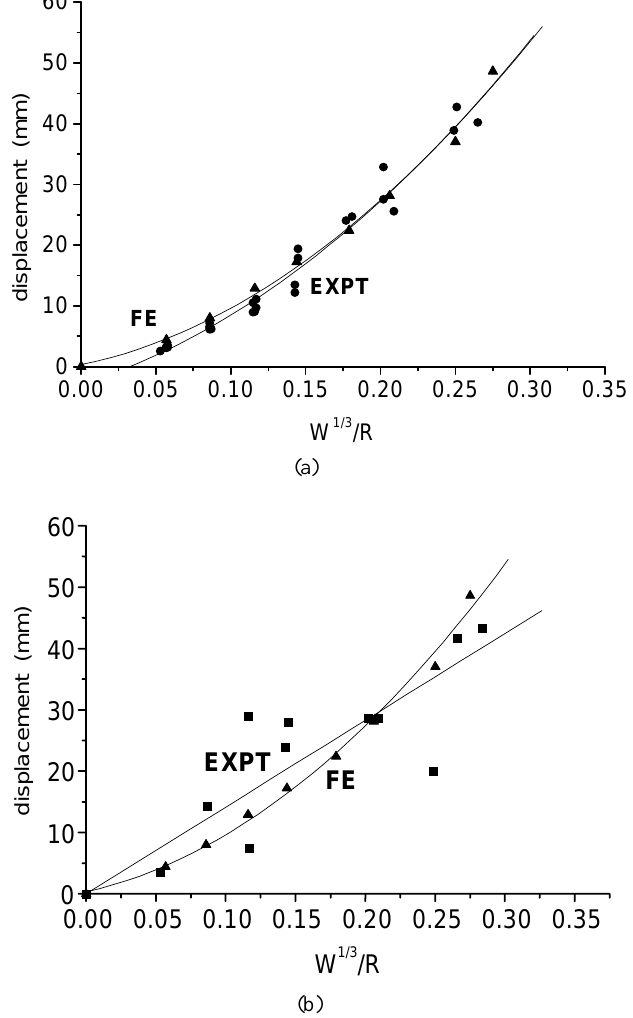
Fig. 8. Comparison of finite element results for deflection of the test plate centre versus experiment data (EXPT) for (a) the doubly integrated accelerometer data and (b) the displacement transducer data. number of events from two displacement